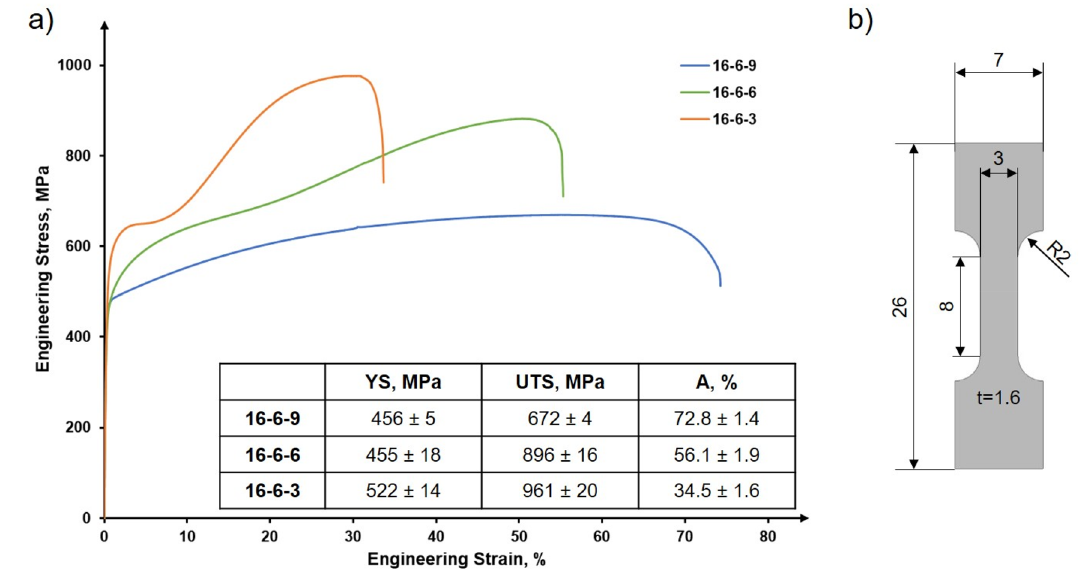
Figure 3. Stress-strain curves of PBF-LB/M-16-6-9, PBF-LB/M-16-6-6 and PBF-LB/M-16-6-3 ( a ); specimen geometry used for tensile tests ( b ). All dimensions are given in mm. The inset shows the average values as well as the standard deviations.